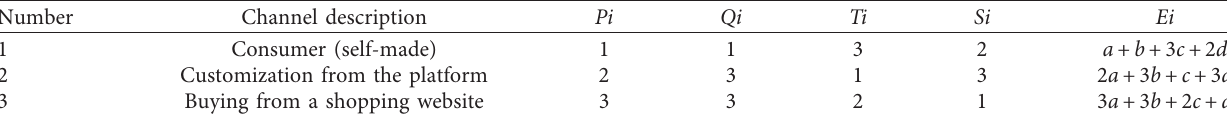
Table 2: Comparison of the comprehensive consumption experience of the 3 channels. Data source: